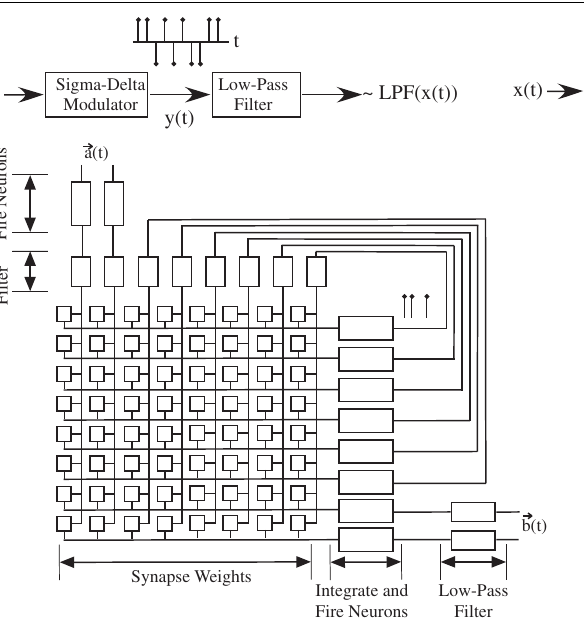
FIGURE 11 | Basic block diagram illustrating the most typical of neural models, that of a fully connected array of synapses, possibly reciprocally connected, connected to an array of neurons. The block diagram on the left is a typical approach for an array of spiking neurons and biologically modeled synapses. The block diagram on the right is a typical approach for an array of neurons with continuous valued outputs; such an approach is called an analog neural network (ANN). The connection between spiking networks and ANN approaches starts with the realization that many neuron models, such as the family of integrate and fire neurons, are effectively linear or weakly non-linear sigma-delta modulators. Typically such functions are used for analog to digital converters (ADC), where the signal (or a low-pass filtered version) is recovered by performing a low-pass filter operation. For neural modeling,